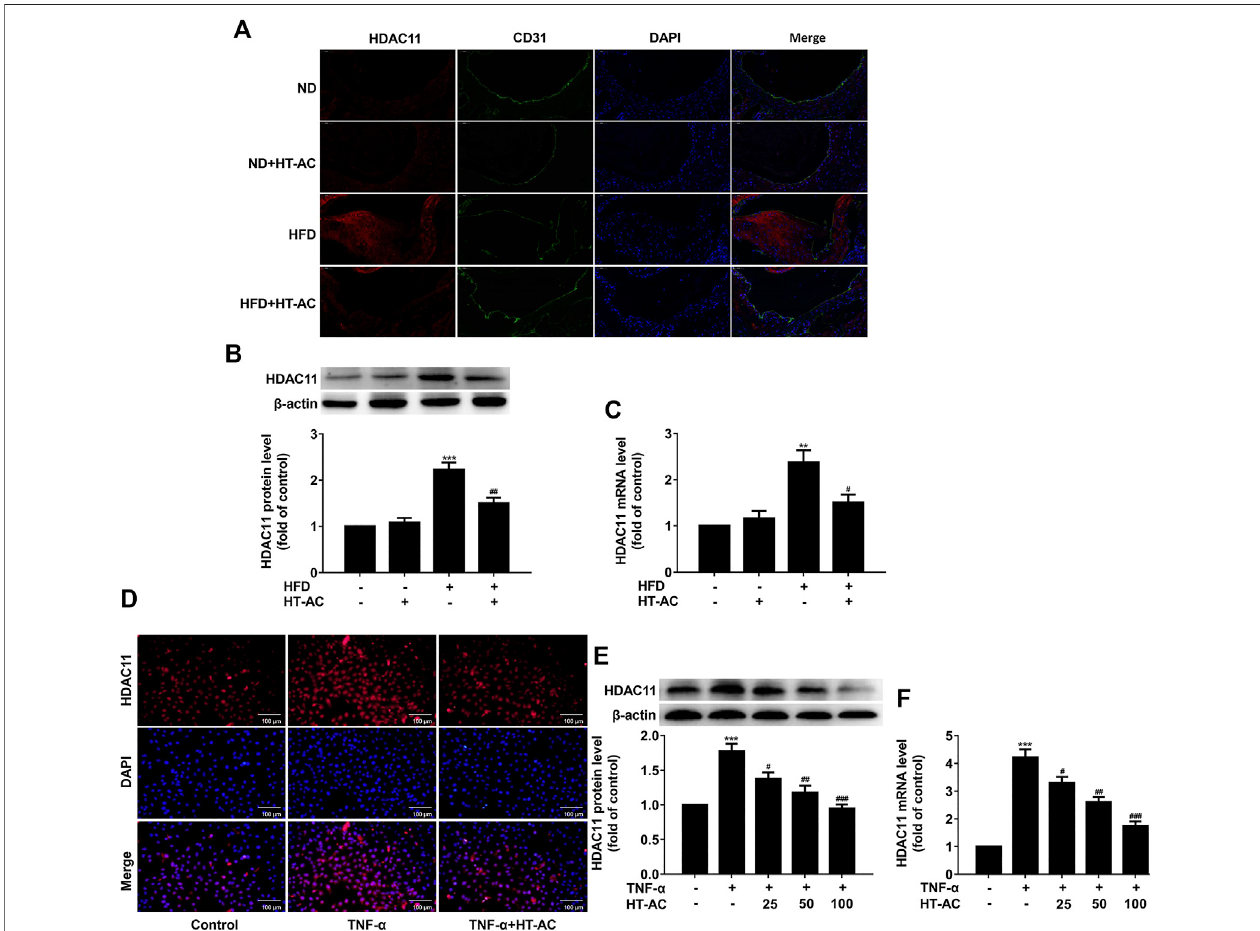
FIGURE4| HT-ACdown-regulatedHDAC11expression (A) TheexpressionofHDAC11intheaorticintimaofApoE − / − micebyimmuno fl uorescentdoublestaining of the aortic sinus of HDAC11 and CD31. Scale bar indicates 50 μ m (B,C) The expression of HDAC11 in the aorta of ApoE − / − mice was determined by Western blotting and quantitative real-time PCR. ** p < 0.01, *** p < 0.001 vs. ND group; # p < 0.05, ## p < 0.01 vs. HFD group. Results are expressed as mean ± SEM (n (cid:2) 10) (D) The expression and localization of HDAC11 in TNF- α -stimulated HUVECs were determined by immuno fl uorescence, × 200. Scale bar indicates 100 μ m (E,F) The expression of HDAC11 in TNF- α -stimulated HUVECs was determined by Western blotting and quantitative real-time PCR. *** p < 0.001 vs. control group; # p < 0.05, ## p < 0.01, ### p < 0.001 vs. TNF- α group. Results are expressed as mean ± SEM ( n (cid:2)